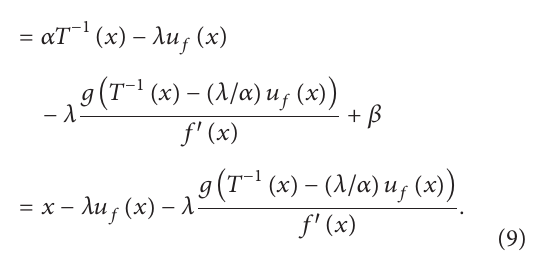
Figure 4: Graphics of